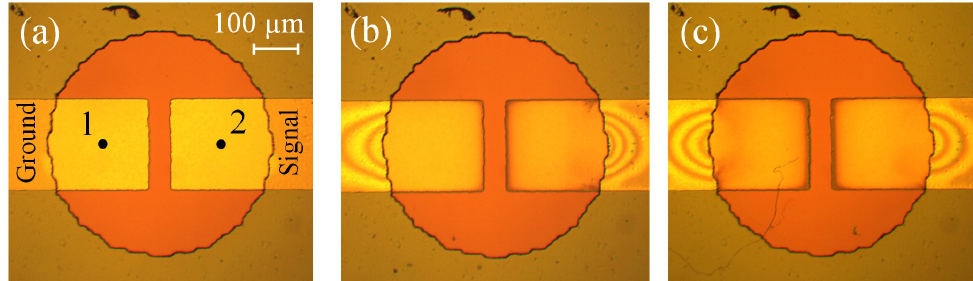
Figure 10. The rectangular electrodes: ( a ) before the test; ( b ) after 60 min of operation in the current stabilization regime with the positive polarity of SP pulses; ( c ) after additional 60 min with the negative polarity pulses.